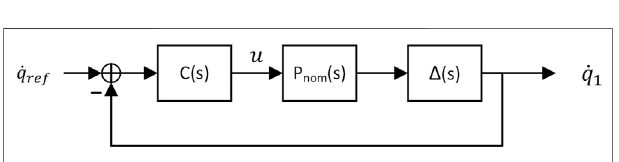
FIGURE 6 | Joint control feedback loop in the presence of a vibrational perturbation.